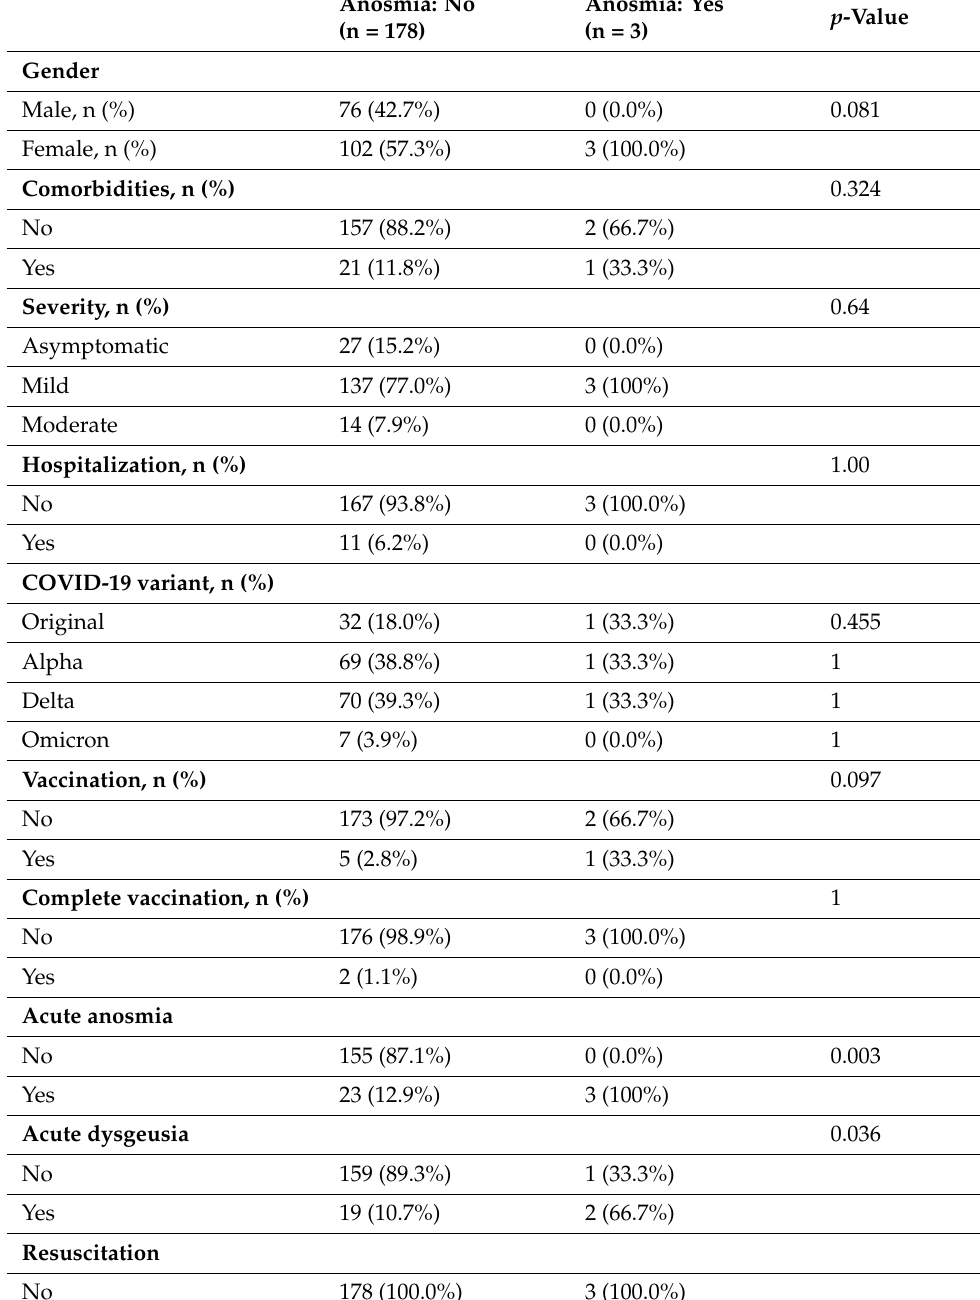
Table 7. Anosmia at FUP